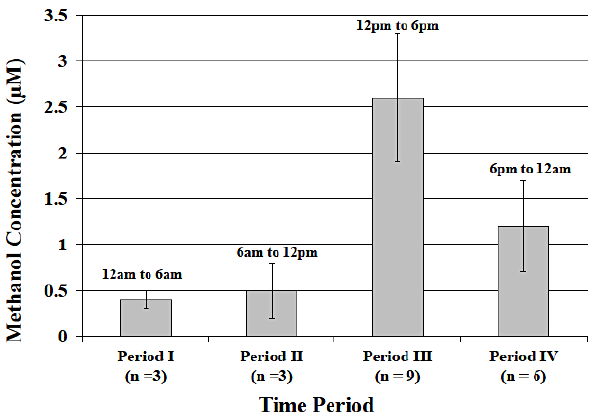
Figure 3. Diurnal methanol concentrations. Each bar represents the average volume-weighted methanol concentration during the given time period. Error bars represent ± one standard deviation from the